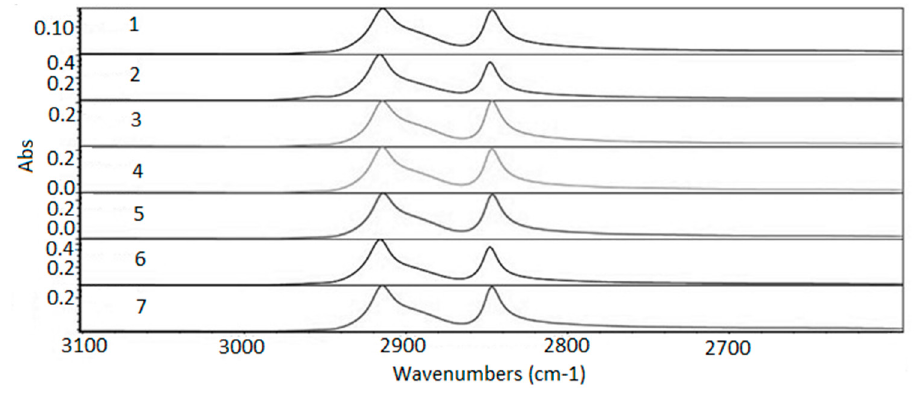
Figure 7. Absorption spectra region from 3100 to 2600 cm − 1 . 1—virgin sample; 2—960 h Xenon arc